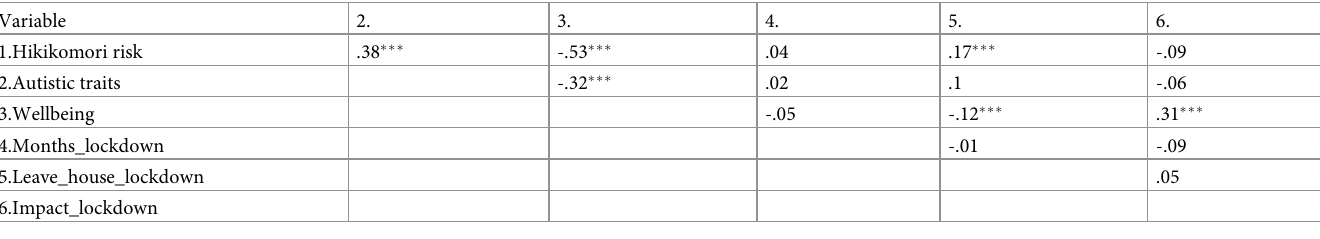
Table 2. Correlations between the study